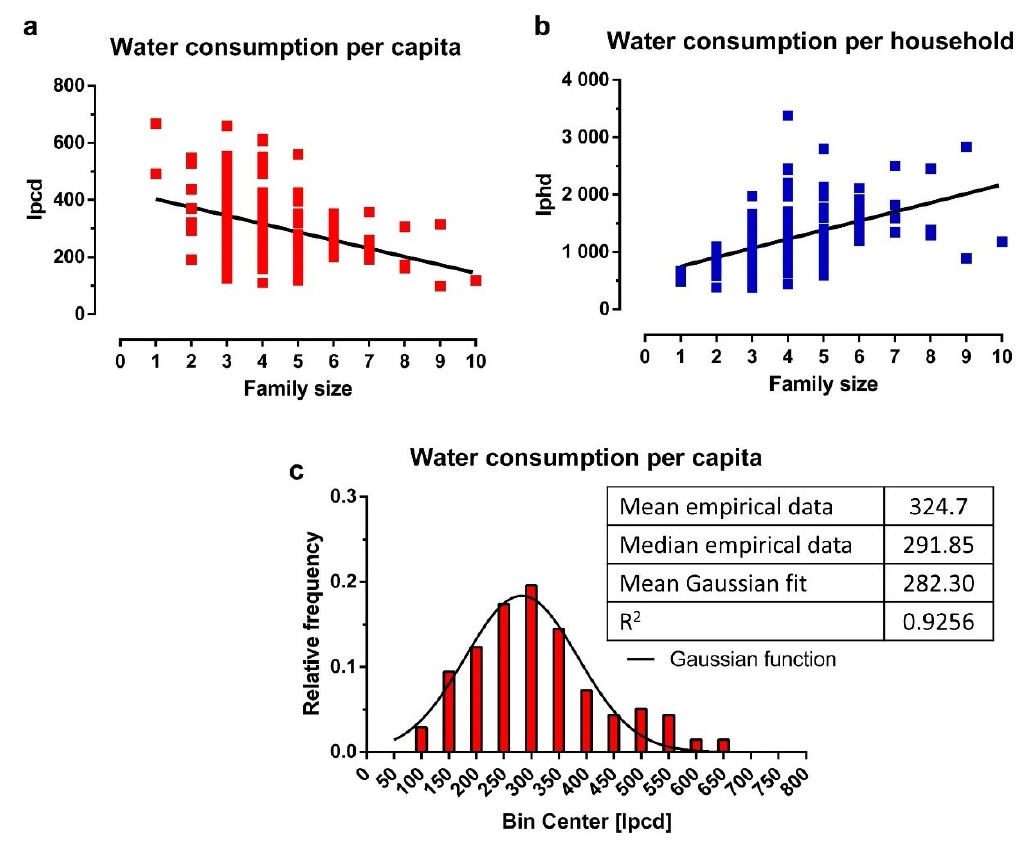
Figure 7. Relationship between family size and ( a ) the water consumption per capita and ( b ) the water consumption per household. The trend line is also presented in each graph. Histogram and Gaussian function for the individual data of ( c ) water consumption per capita per day. The table shows the mean and the median of the empirical data, the median given by the adjustment of the Gaussian model, and the value of R 2 of the adjustment.